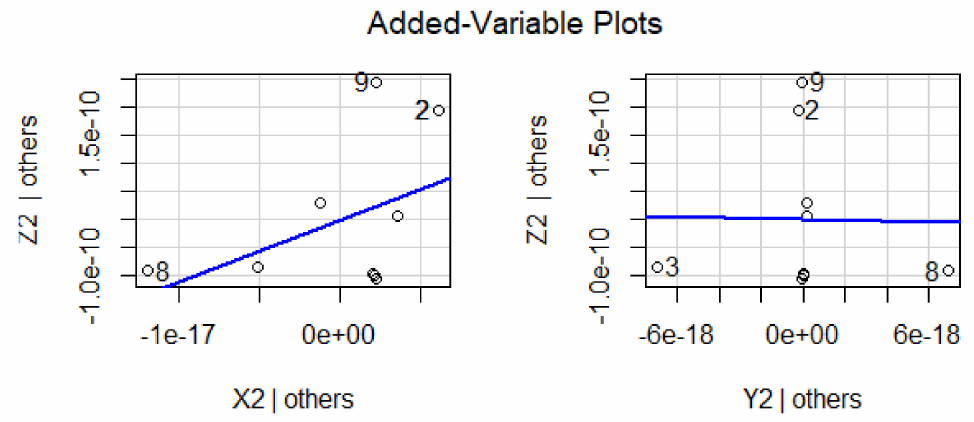
Figure 7. Representation of correlation among the dependent and predictor variables for a difference of 0.03 from the experimentally fixed value at 420 ◦ C.